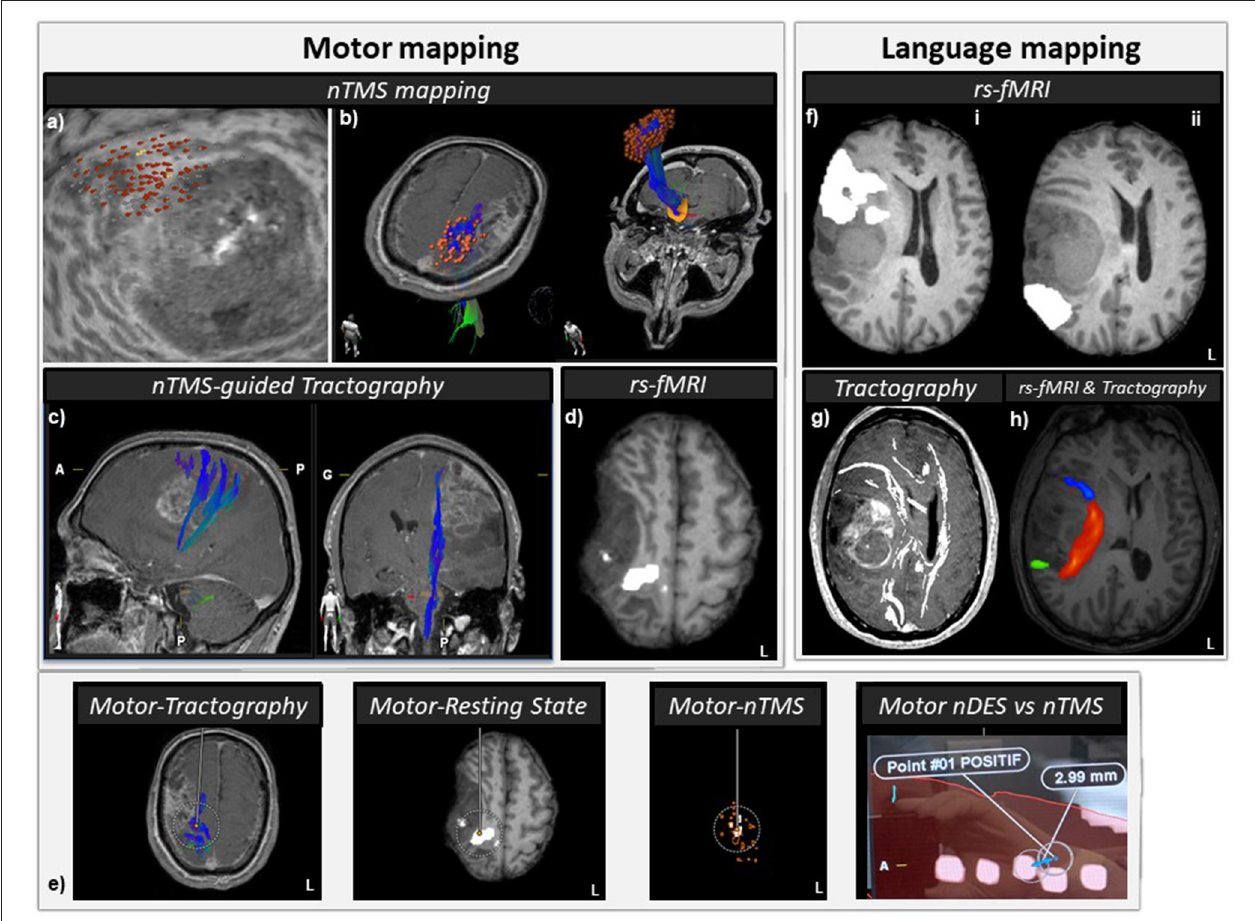
FIGURE 2 | Anatomo-functional peritumoral preoperative mapping. (a) nTMS preoperative motor mapping: red dots represent positive nTMS sites, i.e., where a single pulse TMS elicited a motor evoked potential (MEP) (peak-to-peak amplitude above 50 µ V). The medial and posterior cortical edges of the tumor are at risk during surgery regarding motor function. (b) nTMS-guided functional tractography reconstructions: orange dots stand for positive nTMS sites nTMS, used as seeds to perform functional tractography (red-green-blue tracts). (c) Subcortical display of the motor nTMS-guided tracts located in the vicinity of the medial and posterior edges of the tumor. (d) Resting state functional MRI (rs-fMRI) regions of interest (ROIs) for motor function (white) superimposed on a T1WI axial slice. The posteromedial edge of the lesion seems at risk for motor function during surgery. (e) Peritumoral multimodal motor mapping: preoperative nTMS mapping, nTMS-guided tractography, rs-fMRI, and intraoperative neuronavigated direct electrical stimulation (DES) of the cortical and subcortical regions. Distance between intraoperative neuronavigated positive DES locations and preoperative multimodal positive locations can be accurately measured and then, compensated for brain shift (cf Figure 3 ). After brain shift correction (BSC), distance between DES at 3mA and closest nTMS motor positive point was 2.99mm. (f) Rs-fMRI ROIs (in white) for anterior speech (i) and posterior speech function (ii) superimposed on a T1WI axial slice. The anterior and posterior edges of the lesion might be at risk for speech function during surgery. (g) Anatomical tractography reconstructions of five speech tracts (arcuate (AF)/superior longitudinal (SLF), inferior fronto-occipital (IFOF), frontal aslant (FAT), uncinate (UF), and inferior longitudinal (ILF) fasciculi. (h) Rs-fMRI ROIs for right anterior speech network (blue), rs-fMRI ROIs for right posterior speech network (green), and arcuate/superior longitudinal fasciculus (AF/SLF) anatomical tractography reconstruction. The AF/SLF tract connects some subregions of the anterior and posterior speech rs-fMRI ROIs.